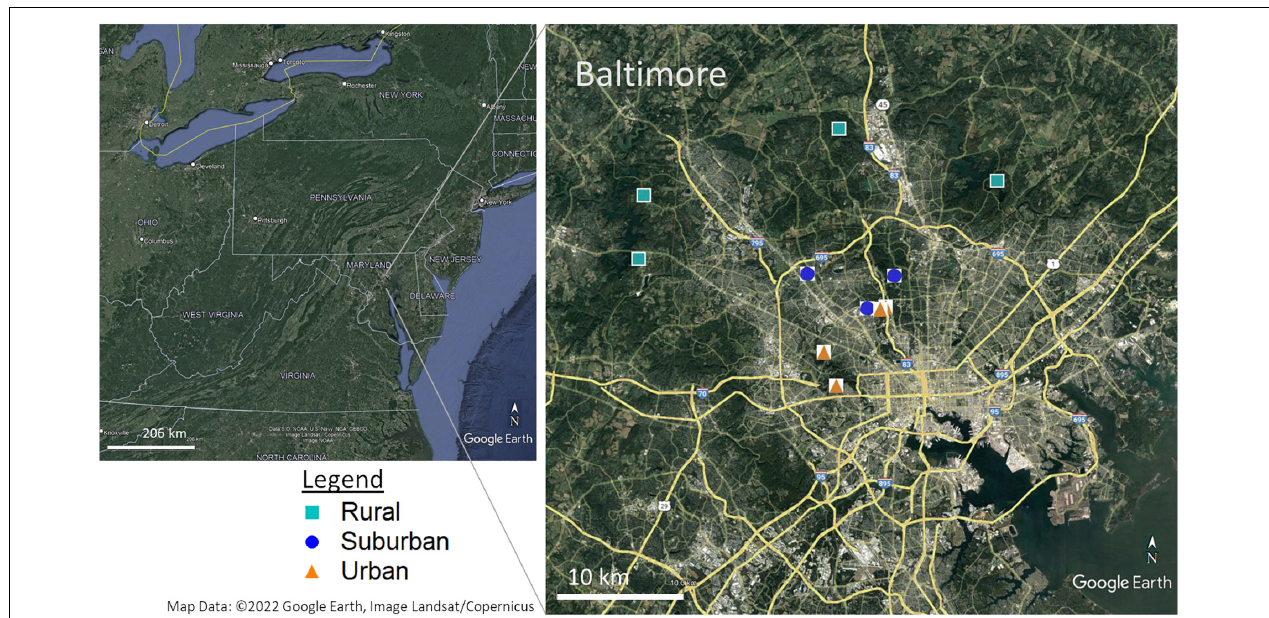
FIGURE 1 | Locations of urban, suburban and rural forest patches in Baltimore City and county. Each symbol indicates a forest patch ( n = 12). Within each patch three plots were established.